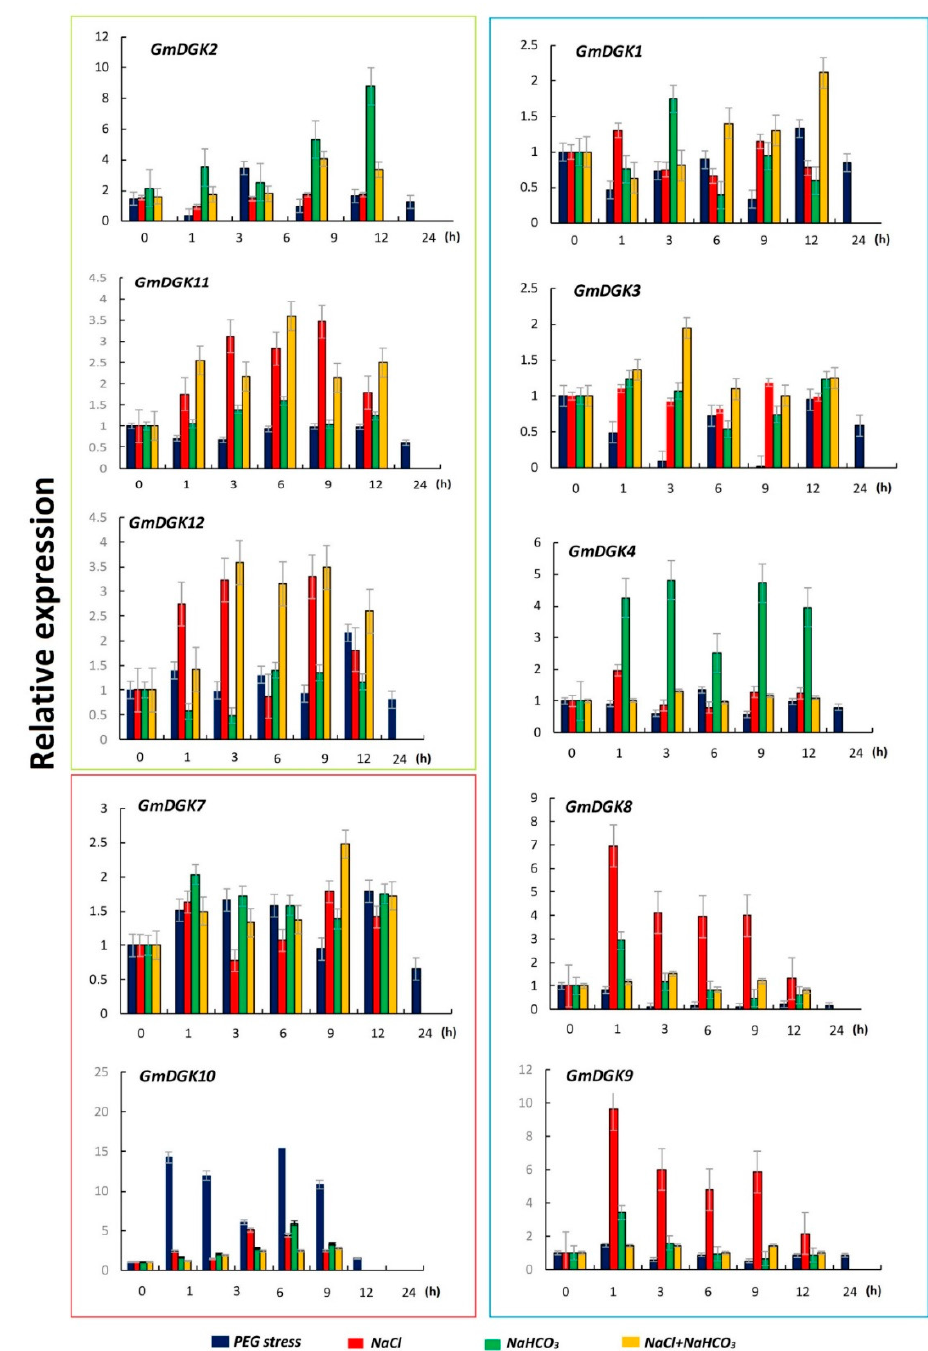
Figure 7. Soybean expression levels of DGK genes in leaf tissues under abiotic stresses with Actin11 as a reference gene; the detection of their expression levels under different stress conditions at different time points is shown.